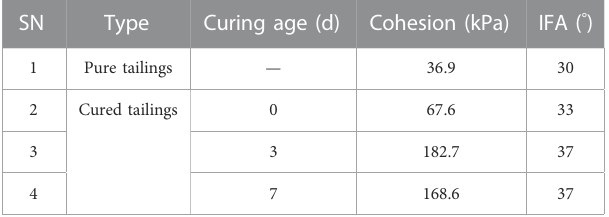
TABLE 2 Triaxial shear test results of concentrated full